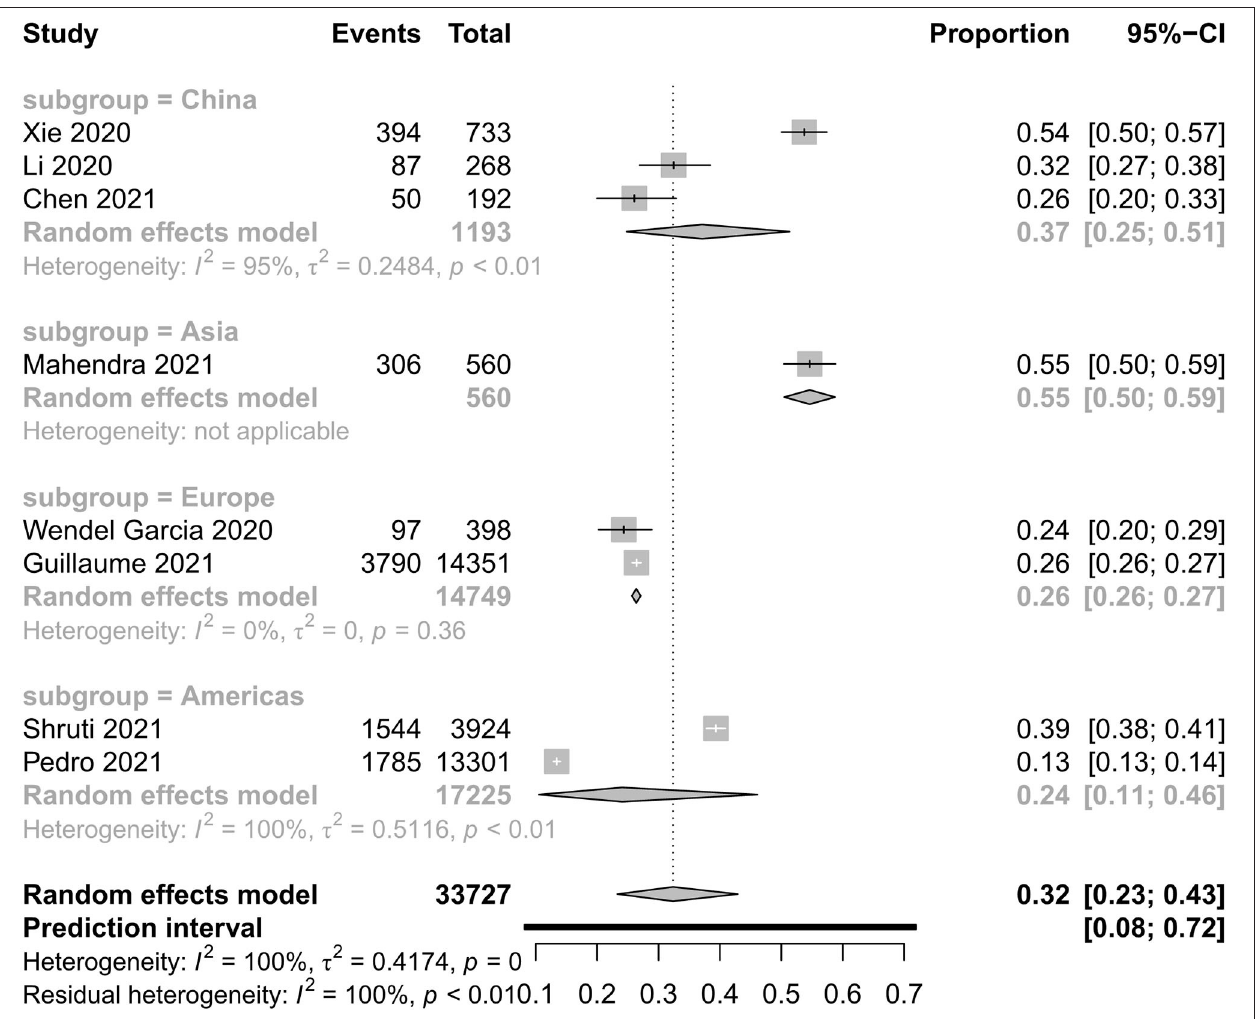
FIGURE 3 | All-cause mortality in hospital with